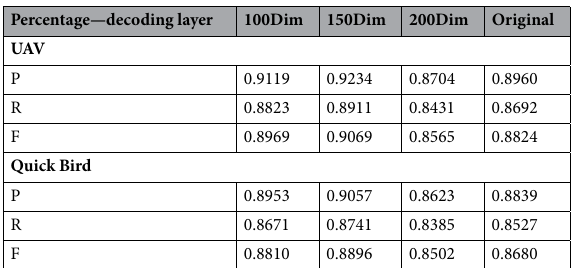
Table 4. Effect of the different word vector dimensions of different sensors on the evaluation criteria